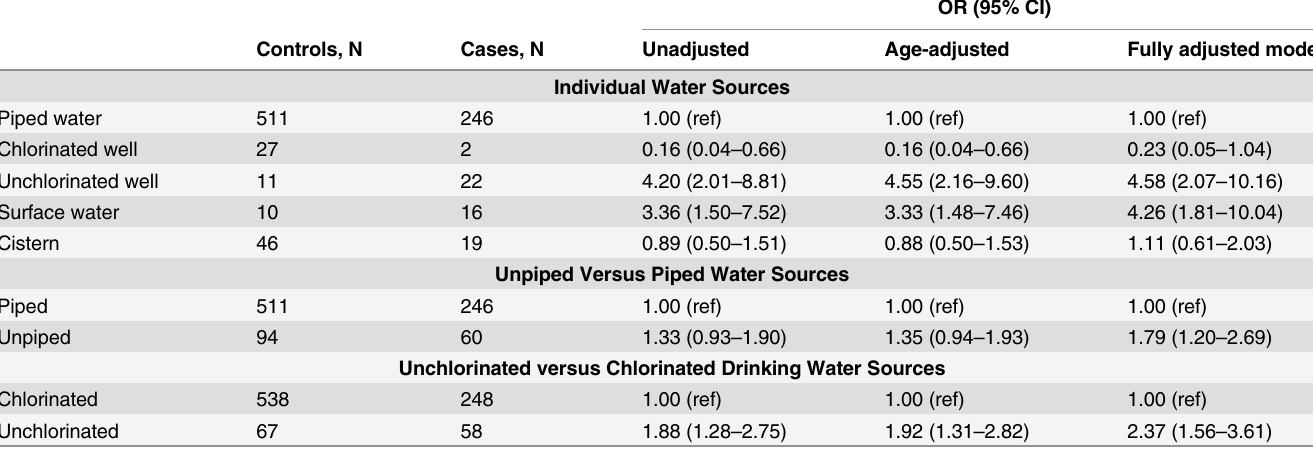
Table 4. Odds Ratios and 95% CIs for Gastric Cancer (GC) by Water